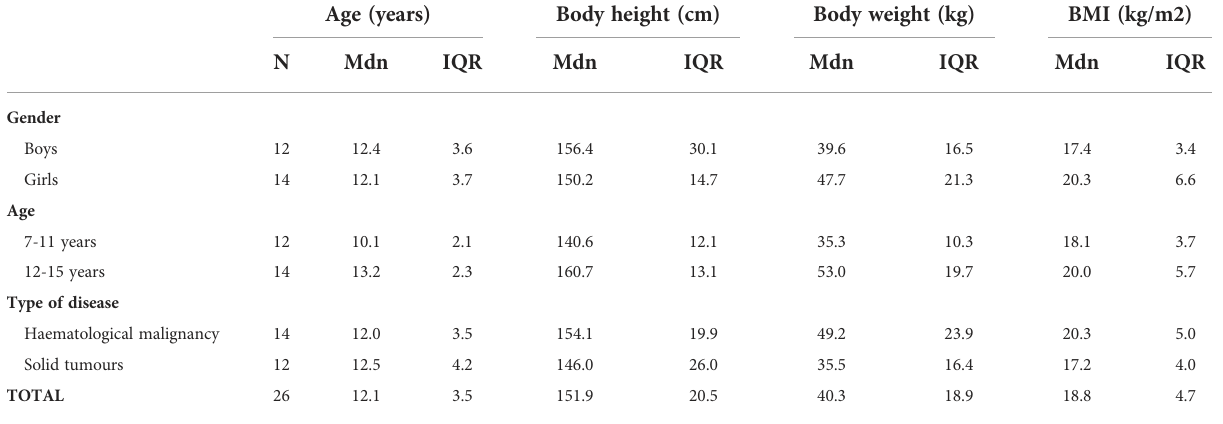
TABLE 1 Descriptive characteristics of the study sample (n = 26).